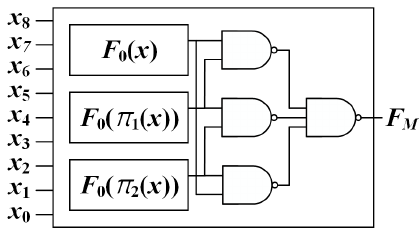
Figure 9. Implementation of F M .